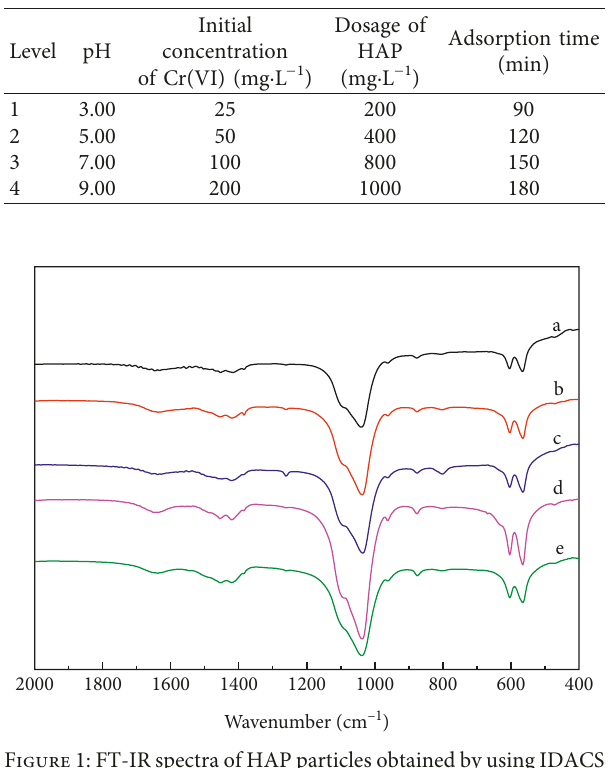
Figure 1: FT-IR spectra of HAP particles obtained by using IDACS as an organic matrix with different molar ratios of chitosan to imidazole-4,5-dicarboxylic acid. a:3:1; b:2:1; c:1:1; d:1:2; e:1:3.